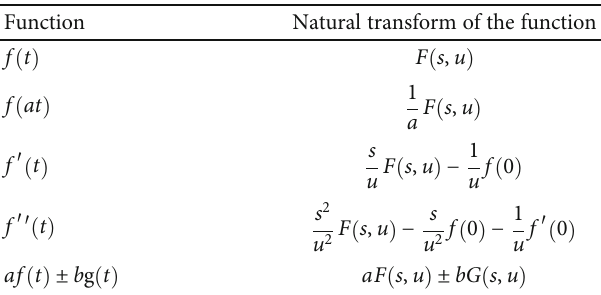
Table 2: Properties of ℕ -transforms. Function Natural transform of the function